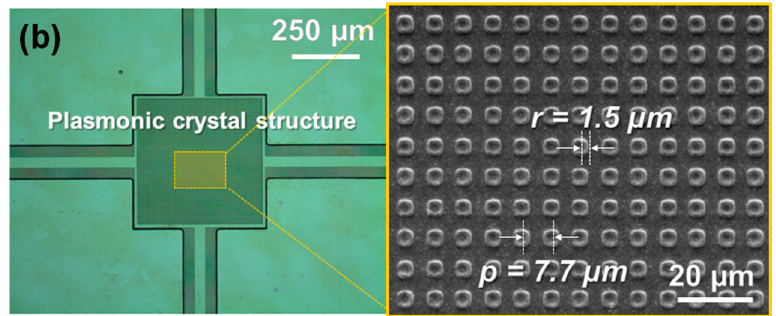
Figure 3. ( a ) Schematic illustration of the fabrication processes of the pyroelectric IR detector with a plasmonic crystal structure; ( b ) An optical microscopy image of the fabricated plasmonic crystal structure along with a magnified scanning electron microscopy image.